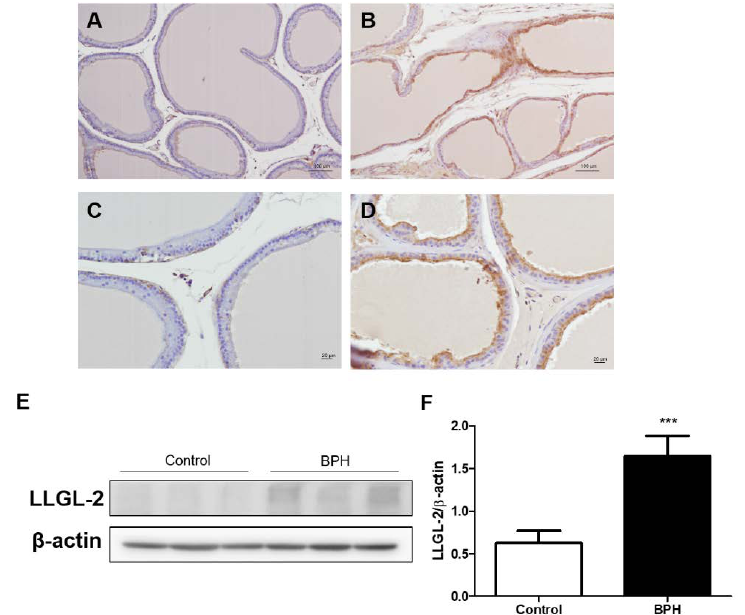
Figure 1. LLGL2 is highly expressed in testosterone-induced rat benign prostatic hyperplasia (BPH) in vivo. Representative photographs of immunostaining for LLGL2 ( A – D ). Prostate of control group; magnifications: × 100, scale bar = 100 µ m ( A ) and magnifications: × 200, scale bar = 20 µ m ( B ). Prostate of BPH group; magnifications: × 100, scale bar = 100 µ m ( C ) and magnifications: × 200, scale bar = 20 µ m ( D ). ( E ) LLGL2 protein expression in testosterone-induced rat BPH prostate tissue by Western blotting. ( F ) Graphical representation of the ratio of LLGL2 to β -actin. Values are expressed as the means ± standard deviation; *** p < 0.001 versus control group.